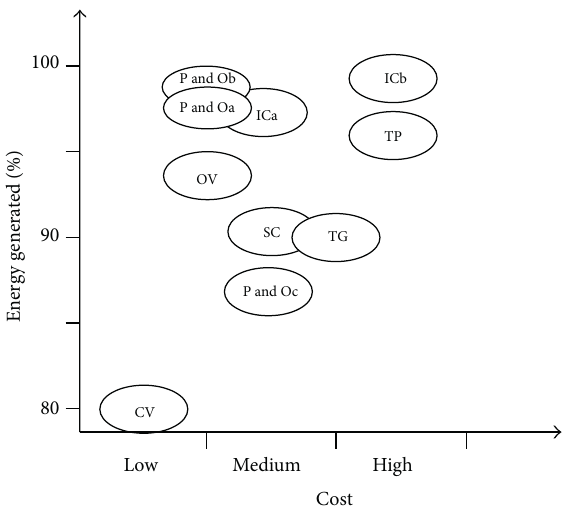
Figure 2: Comparison of the MPPT methods [12].